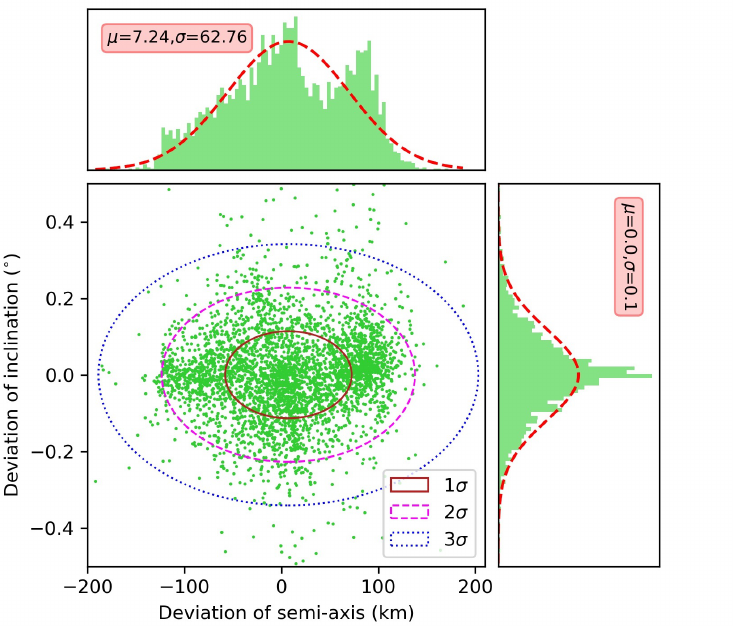
Figure 4. Accuracy of ρ R calculation